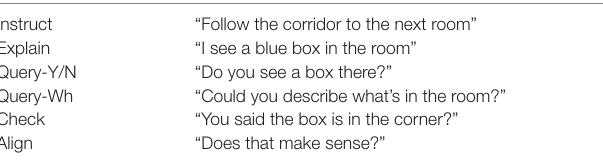
TaBle 1 | Initiation moves and